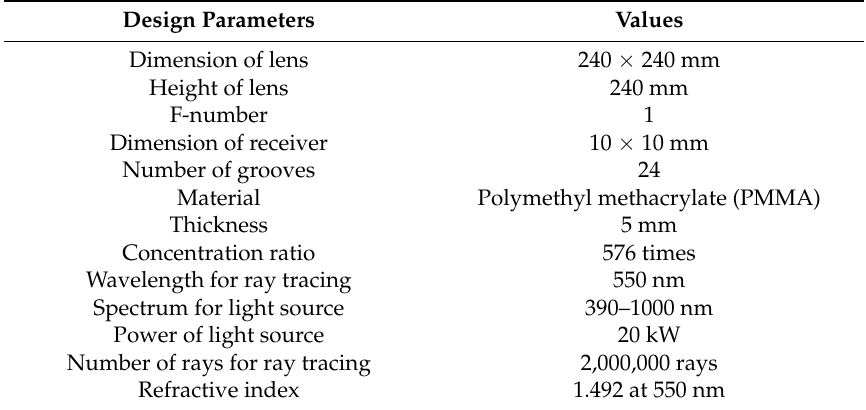
Table 1. The parameters of the designed linear Fresnel lens for ray tracing and